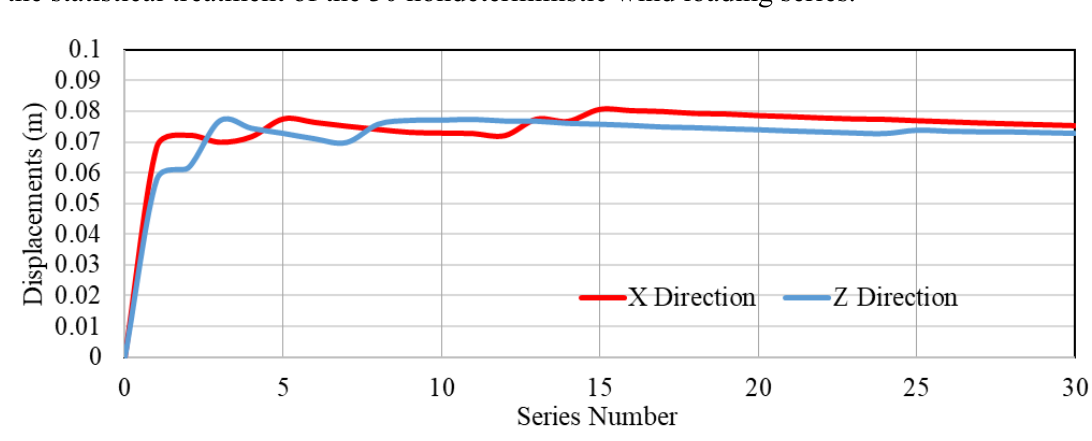
Fig. 7. Convergence of the horizontal displacements: Model M2 (X and Z directions).